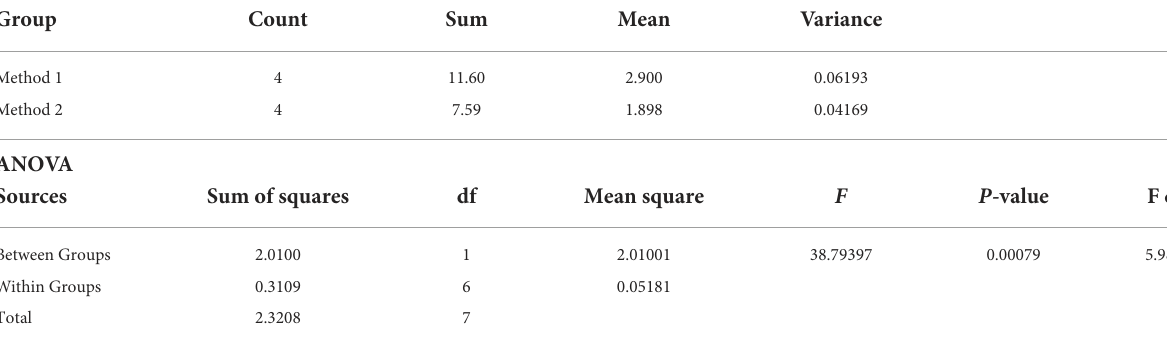
TABLE 12 One-way ANOVA of perceived barriers between rural and urban